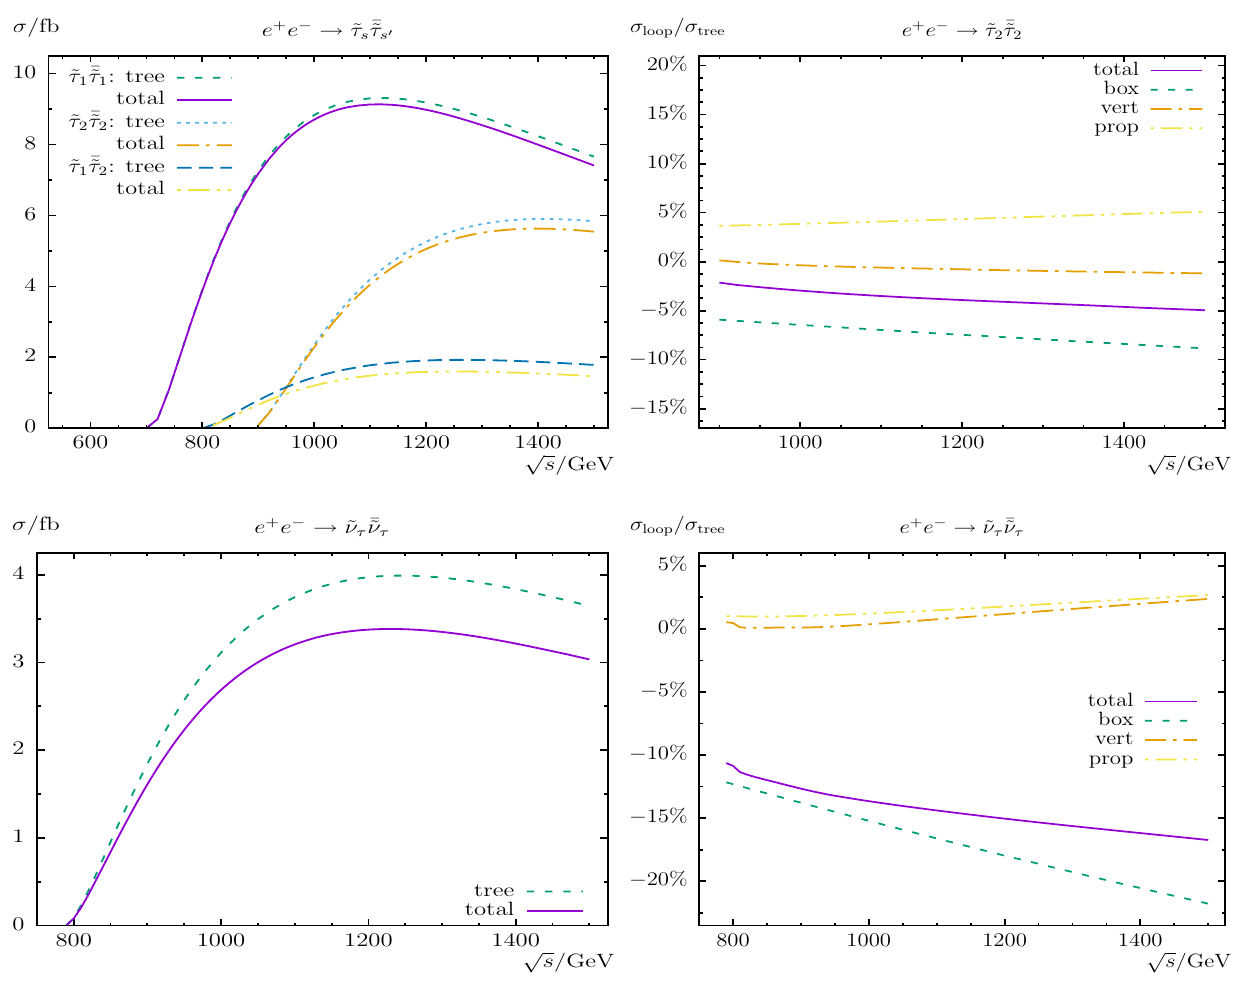
) (lower row). The left (right) plot shows cross sections τ